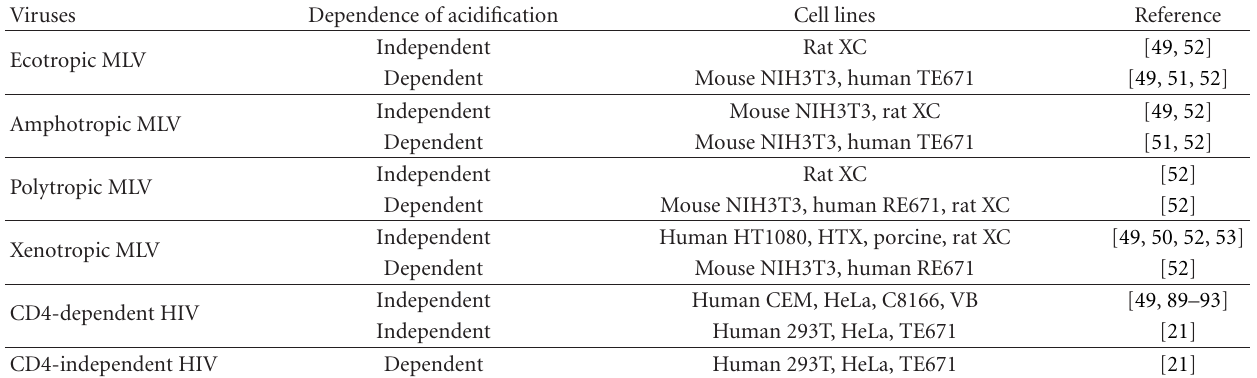
Table 2: Di ff erential dependence of HIV and MLV infections on endosome